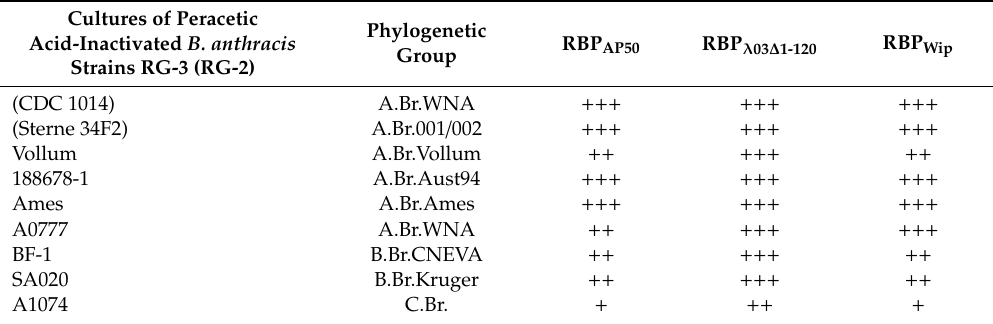
Figure 5. Binding of RBP reporters to inactivated cells of B. anthracis CDC1014. Cells were either inactivated by heat, formaldehyde or peracetic acid treatment. Inactivated cells or live control cells (from the same culture) were incubated with RBP reporters (RBP AP50 , RBP λ 03 ∆ 1-120 or RBP Wip ) and subjected to fluorescence microscopy. Representative micrographs recorded as merged light and fluorescence channels are shown. Scale bar: 10 µ m. Table 2. Labeling of RG-3 B. anthracis cells with RBP reporters 1